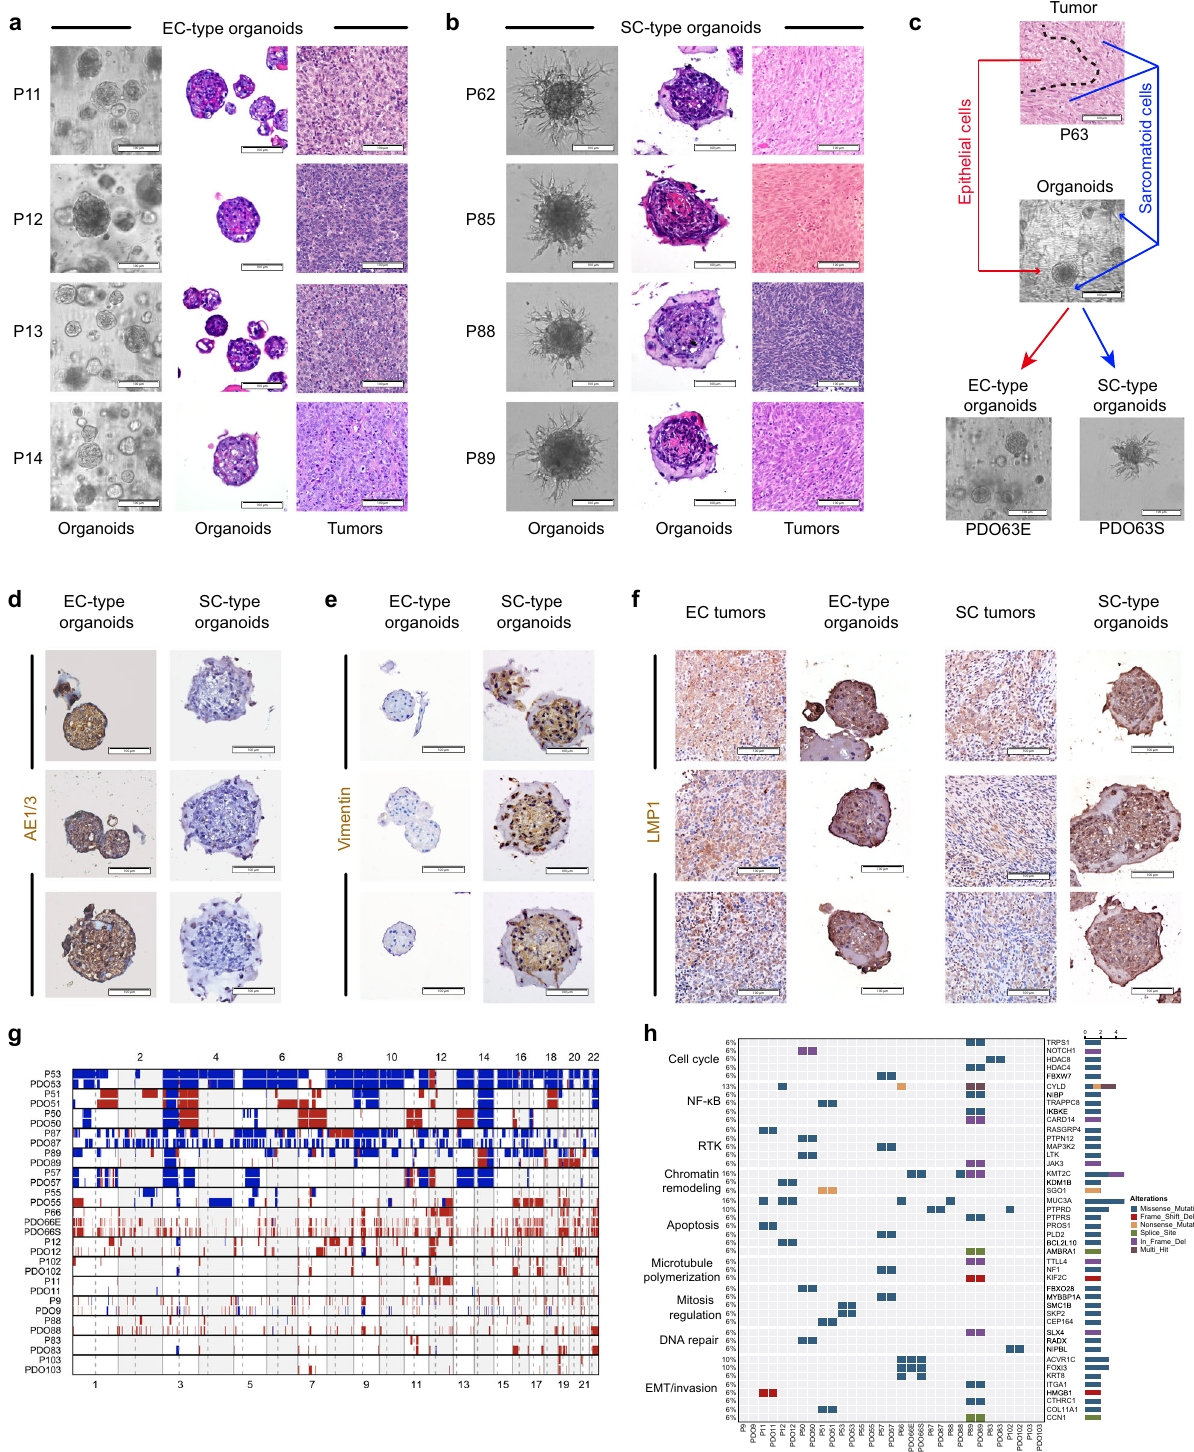
PDOs for the majority of pairs (Fig. 3g). Similarly, paired tumors and PDOs maintained consistent mutational signature pro fi les (Supplementary Fig. 7a,b). Furthermore, the cancer related gene mutations in parental tumors, thought to be tumor-speci fi c drivers, were preserved in most paired PDOs (Fig. 3h). Since there were two morphologically distinct cell populations observed in same MSEC tumor, it was of interest to explore whether they originated from same clone or polyclone. WES analysis on paired